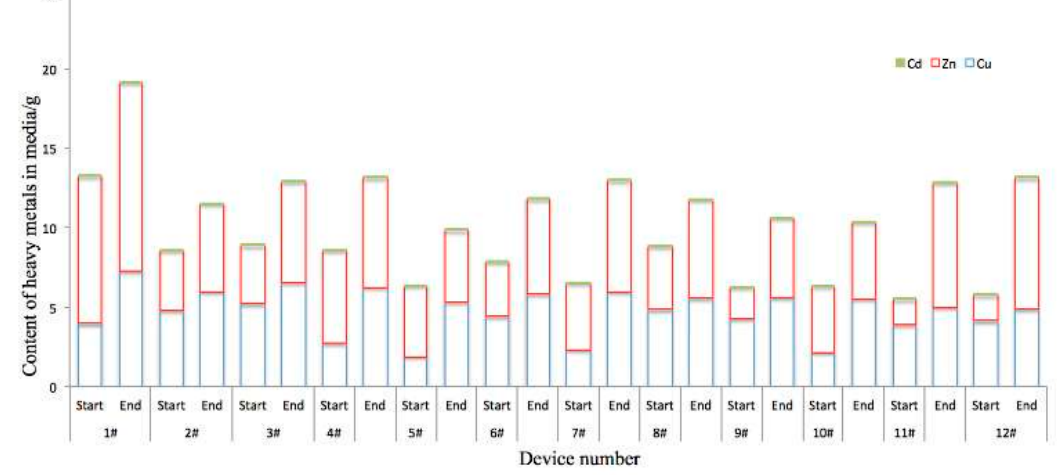
Figure 6. Content of heavy metals in media.